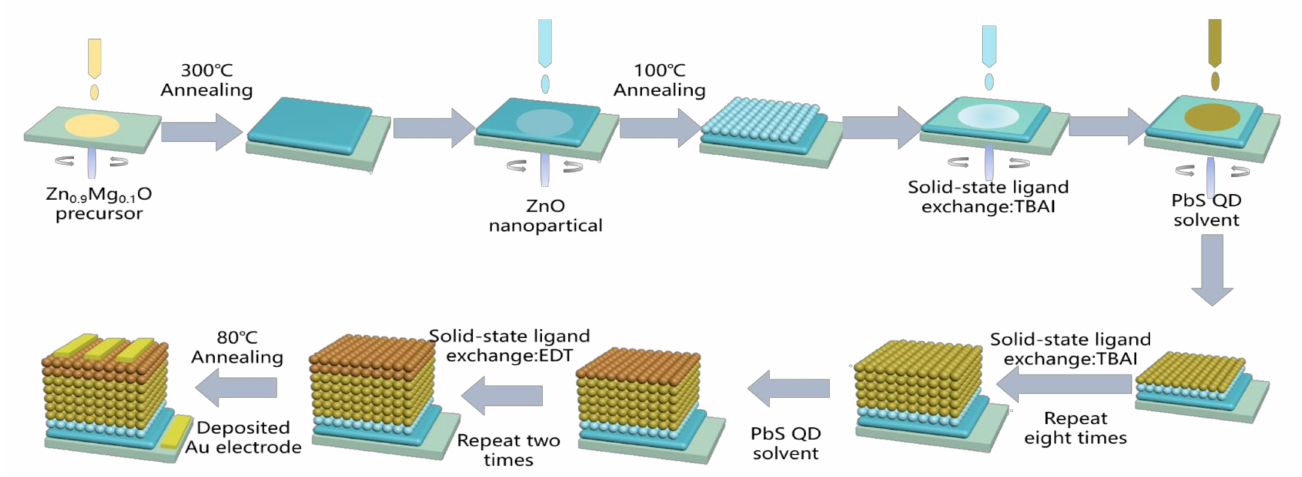
Figure 1. A schematic of PbS colloidal quantum dot (CQD) solar cell fabrication process under ambient conditions using layer-by-layer solution